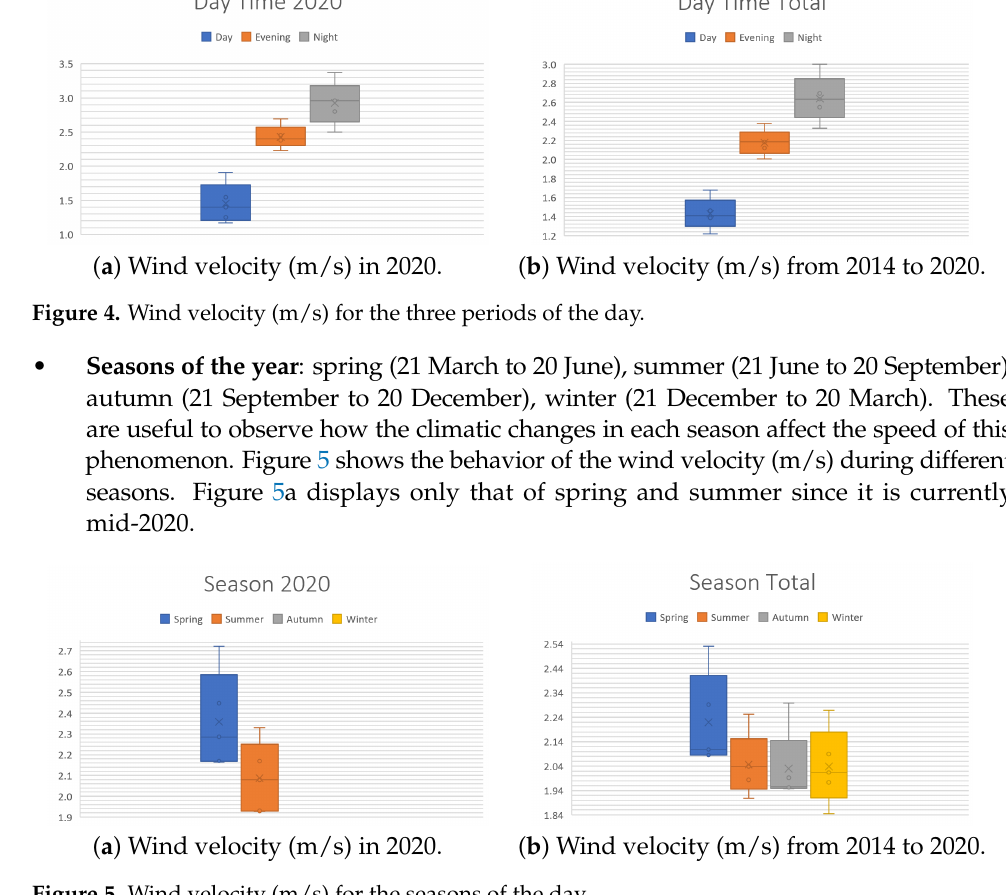
Figure 5. Wind velocity (m/s) for the seasons of the day.